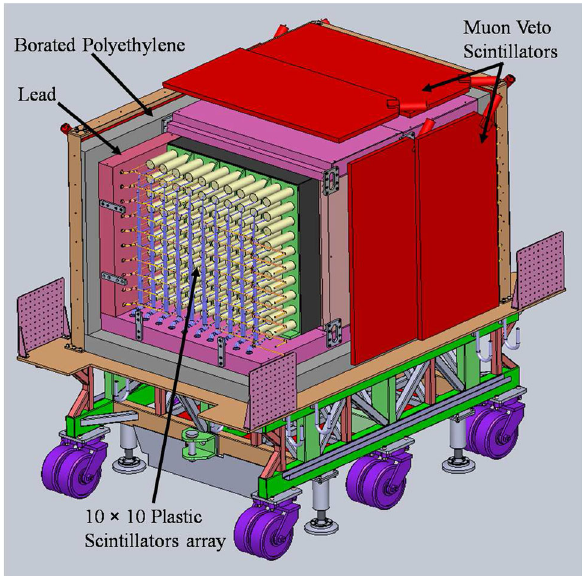
Fig. 1 Schematicof100cm × 10cm × 10cmplasticscintillatorsarray with shielding materials for reactor antineutrino